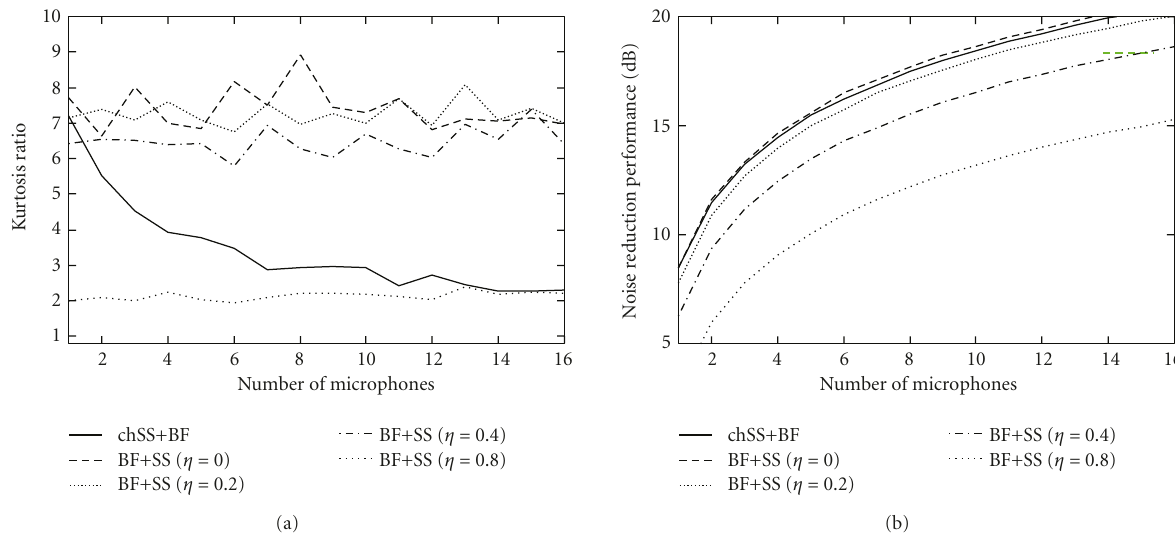
Figure 15: Results for Gaussian input signal. (a) Kurtosis ratio and (b) noise reduction performance for BF+SS with various flooring